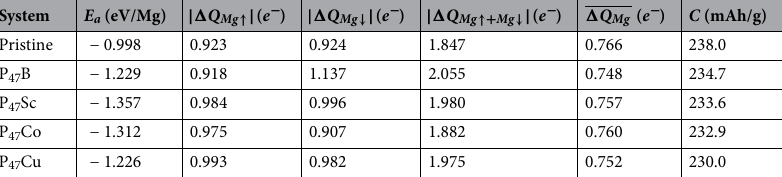
Table 2. Calculated adsorption energy ( E a ), absolute charge transfer from double-side adsorbed single Mg (Mg ↑ : Mg adsorbed to upper side, Mg ↓ : Mg adsorbed to bottom side), total absolute charge transfer from Mg on both sides (cid:31) Q Mg ↑+ Mg ↓ to substrate, average charge transfer of adsorbed 24 Mg atoms on both sides ( (cid:31) Q Mg ), and storage capacity of BP substitutionally doped by B, Sc, Co and Cu atoms with double-side Mg fully